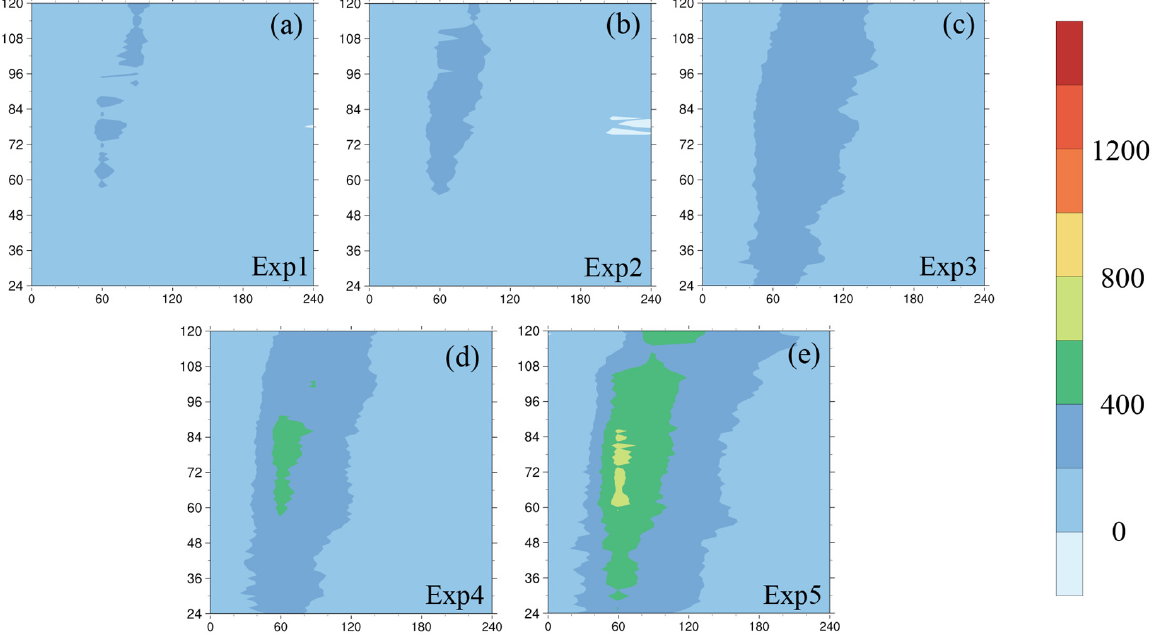
Figure 15. Hovmöller diagrams of the azimuthally averaged sensible heat flux H S , T simulated by the five experiments ( a – e ). The abscissa is the radial distance from the center of the TC, and the ordinate is the simulation time. Figure 16a,b reflect the evolution of the average total latent and sensible heat fluxes ( H L , T and H S , T ) within 150 km from the TC’s center as simulated by different experiments with the simulation time. It can be seen that the H L , T and H S , T calculated by the different experiments are quite different. In the same experiment, the heat transfer by the latent heat is more